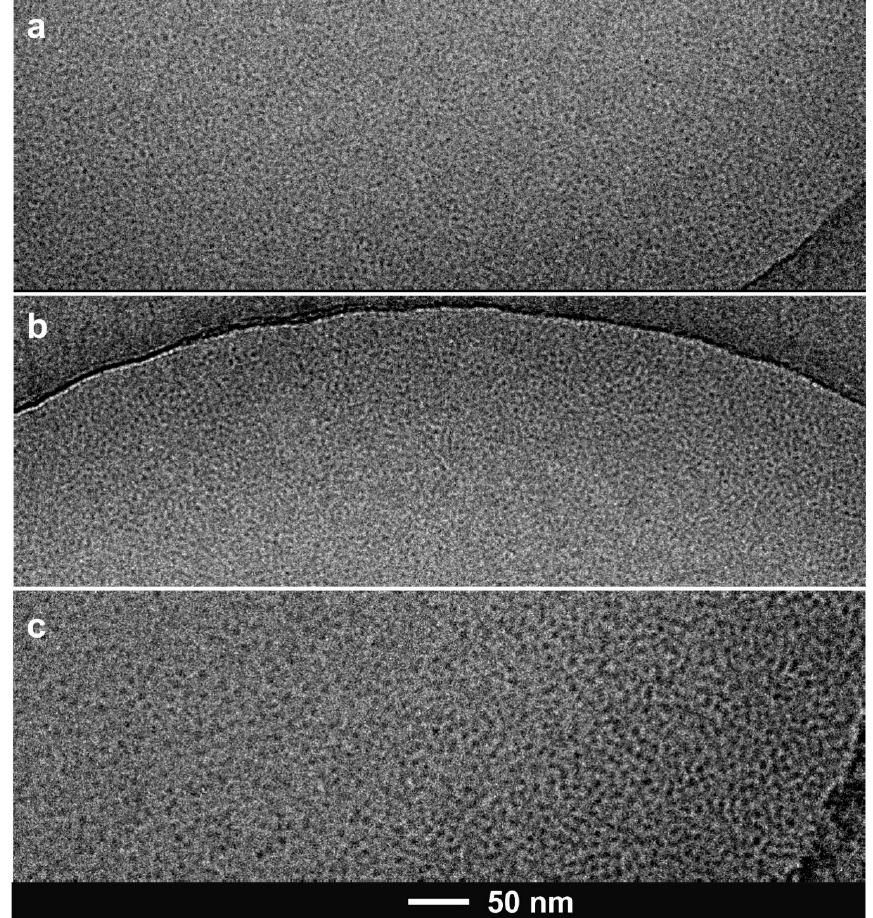
Figure 2. Cryo-TEM images of polymers, ( a ) 5a ; ( b ) 5b showing individual spherical micelles in the diameter range of 5 nm; ( c ) Cryo-TEM image of individual spherical micelles of ~8 nm in diameter formed upon encapsulation of curcumin encapsulated by polymer 5a .